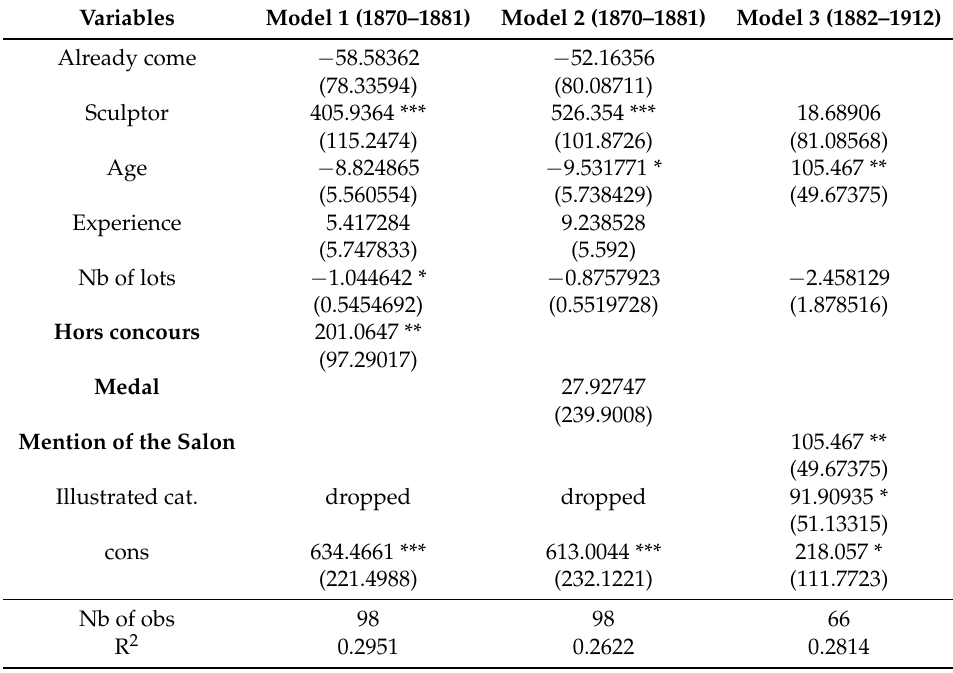
Table A2. Results of the hedonic regression, conducted on auction sales that were organized by the artists themselves for their own works. The explained variable is the average sales revenue, in constant 1890